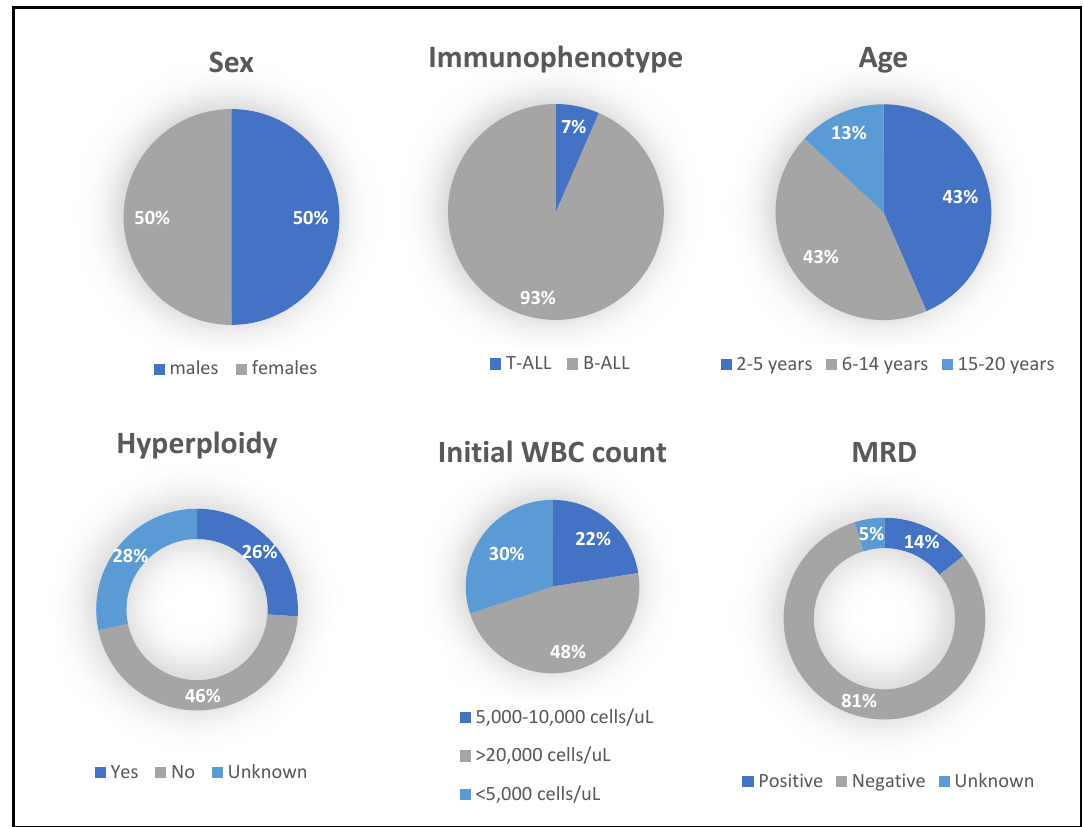
Figure 6. Demographics of ALL subjects . WBC: white blood cells. MRD: minimal residual disease. Table 1. Demographic and clinicopathological features of ALL subjects.